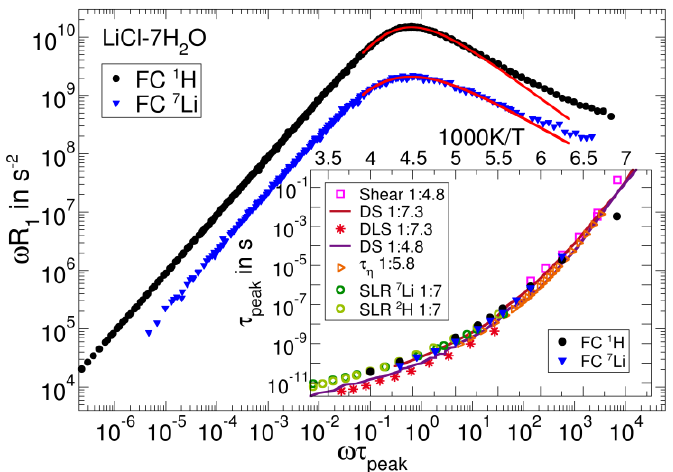
Figure 7. 1 H (black circles) and 7 Li (blue triangles) FC master curves of LiCl-7H2O on a reduced frequency axis, which is defined by the respective peak correlation times τ peak form KWW fits to the peak regions (red lines). The inset compares the FC peak correlation times with data from shear relaxation [119], DS [117], DLS [117], viscosity measurements [116], and conventional HF NMR [118] for the indicated aqueous salt solutions.